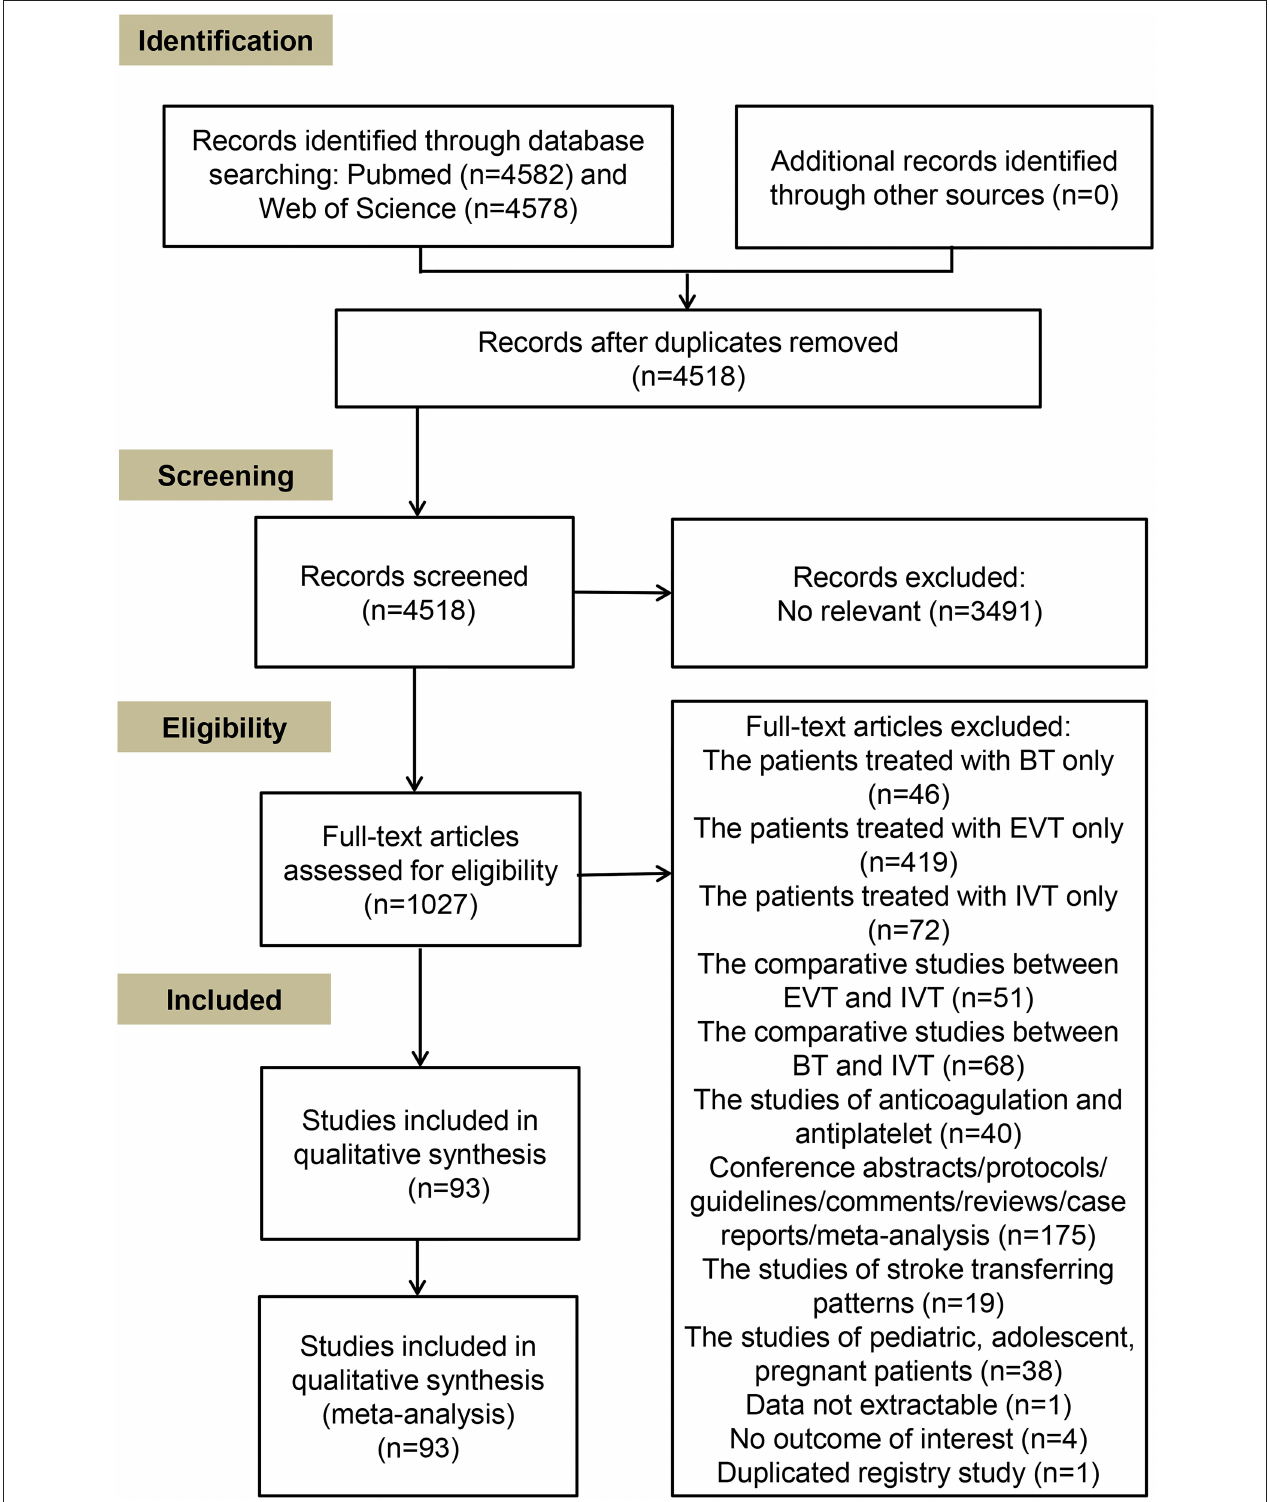
FIGURE 1 | Flow chart for manuscripts selection in this meta-analysis.